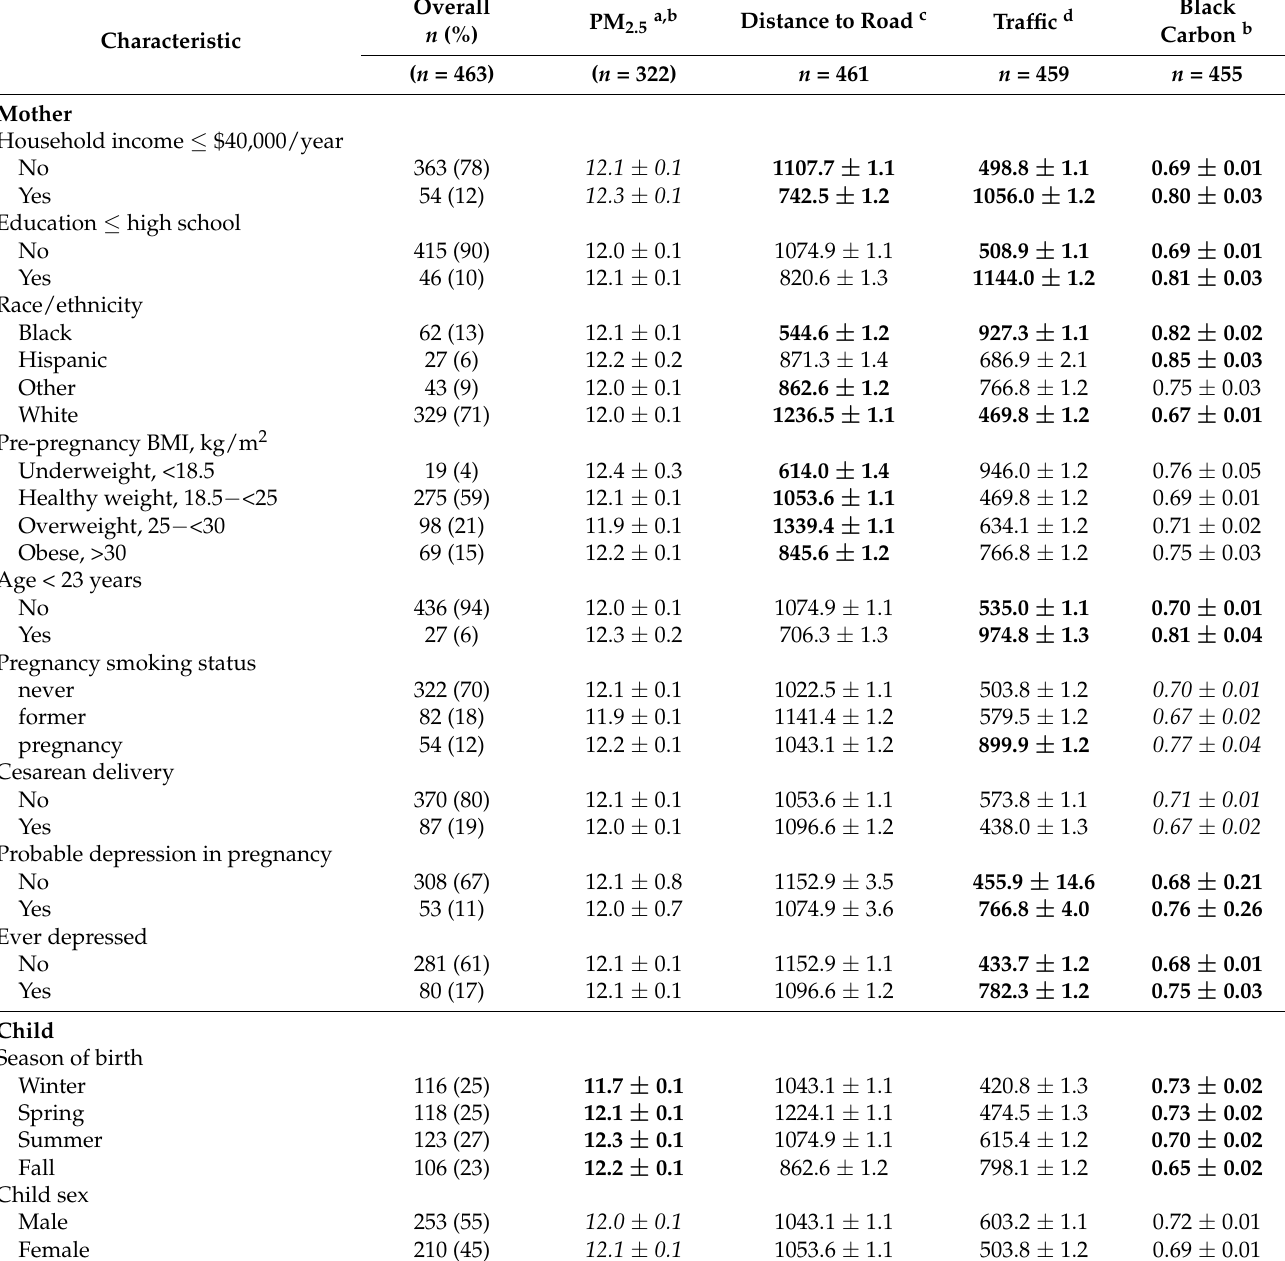
Table 1. Air pollution means ± standard errors according to participant